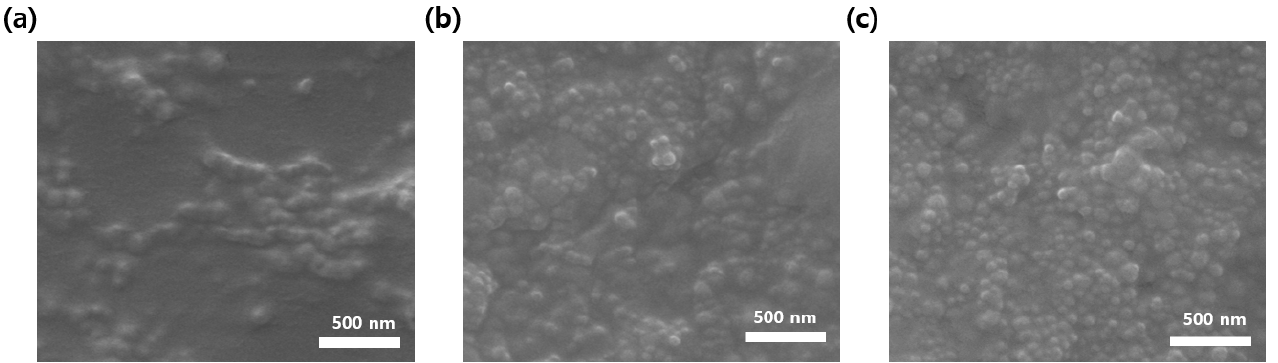
Figure 6. SEM images of coating surfaces. ( a ) PIFSS-5, ( b ) PIFSS-10 and ( c ) PIFSS-15.